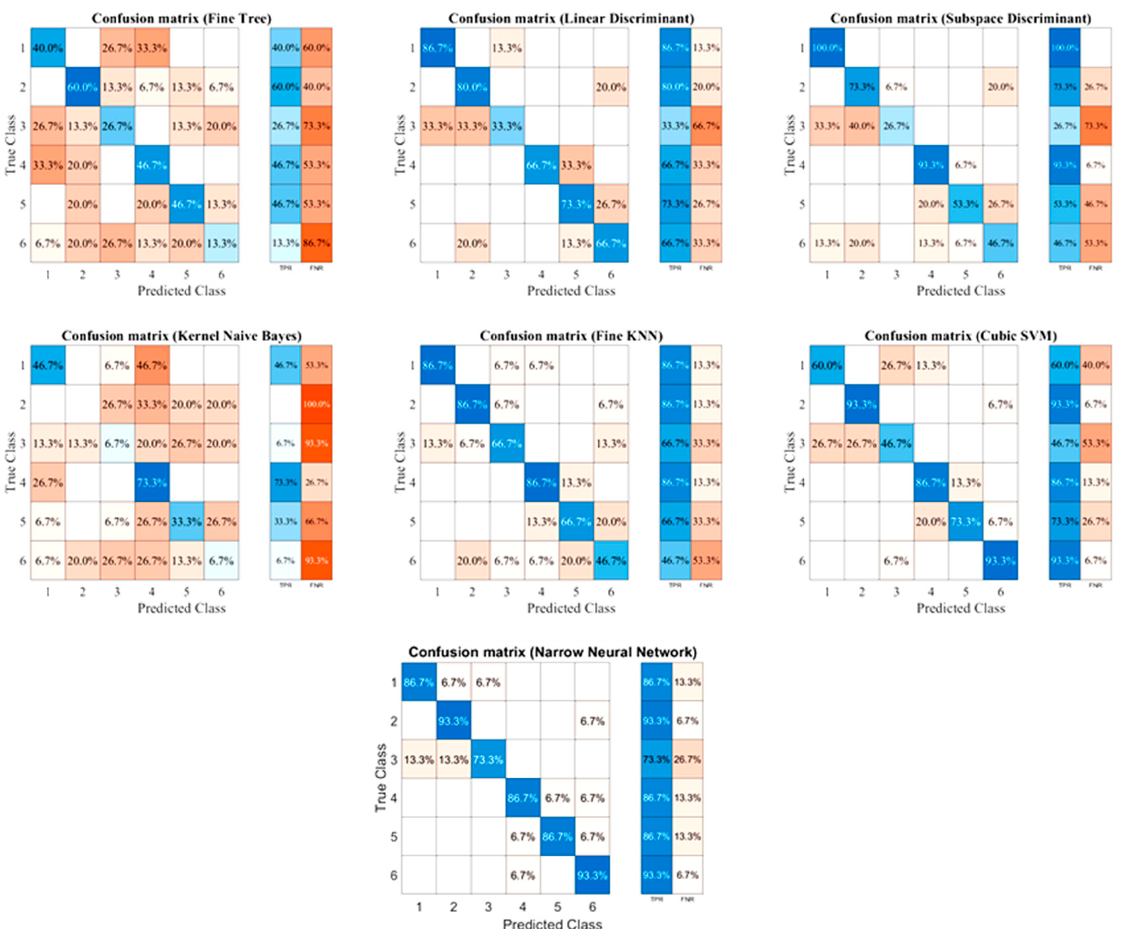
Figure A1. The accuracy of different machine learning classifiers represented by confusion matrix. We included only highest accuracy classifier from each group. 1, 2, 3, 4, 5, and 6 represented OV-90/Parental, OV-90/CisR1, OV-90/CisR2, SKOV-3/Parental, SKOV-3/CisR1 and SKOV-3/CisR2, respectively. TPR=true positive rates, FNR = false negative rates.